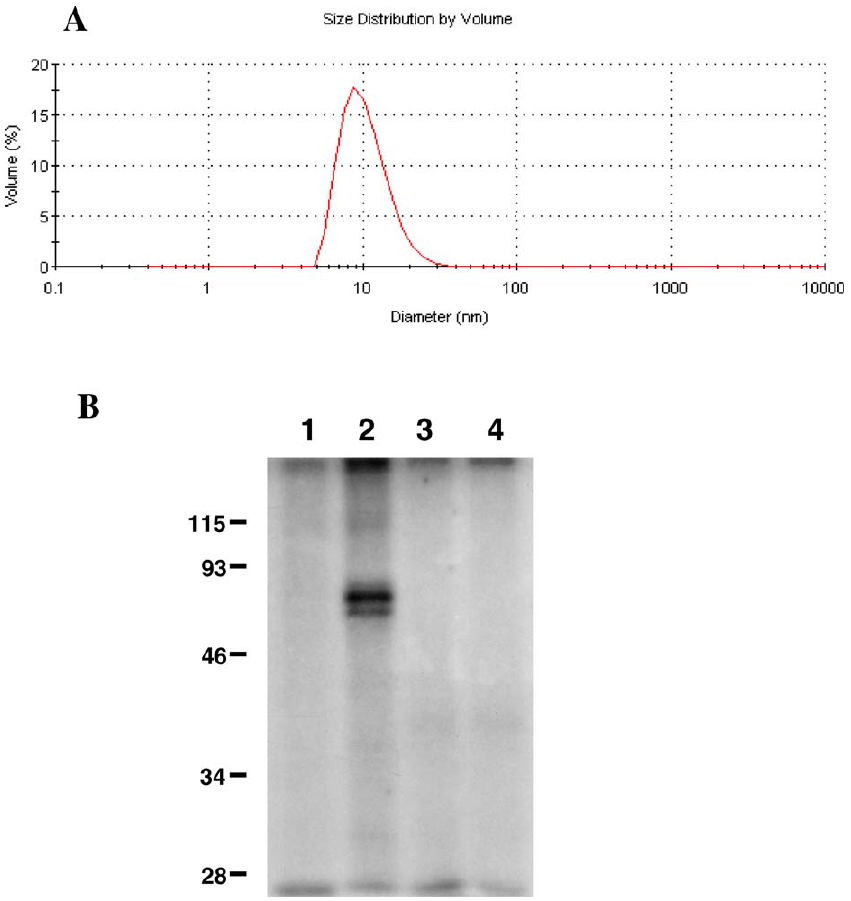
Figure 7. ROP18 Is an Active Kinase (A) DLS of recombinant kinase domain of ROP18. Refolding was performed on the recombinant ROP18 solubilized in Gdn-HCl and monitored by DLS. Ten-fold dilution was directly performed into the cuvette and light scattering measured after 1 min. Trial-and-error led to an optimal solution in which refolded ROP18 appeared as a monodisperse entity roughly 10 nm in size (without taking into account the viscosity of the refolding buffer). (B) SDS-PAGE autoradiography of a kinase assay of the recombinant kinase domain of ROP18. In lanes 2 and 4, the recombinant His-tagged ROP18 produced in E. coli was refolded, purified, and incubated with tachyzoite lysate (lane 2) or HFF lysate (lane 4) in the presence of [ c 32 P-ATP], whereas in lanes 1 and 3, the recombinant His-tagged ROP18 mutated on aspartate 394 was used with tachyzoites (lane 1) or HFF lysate (lane